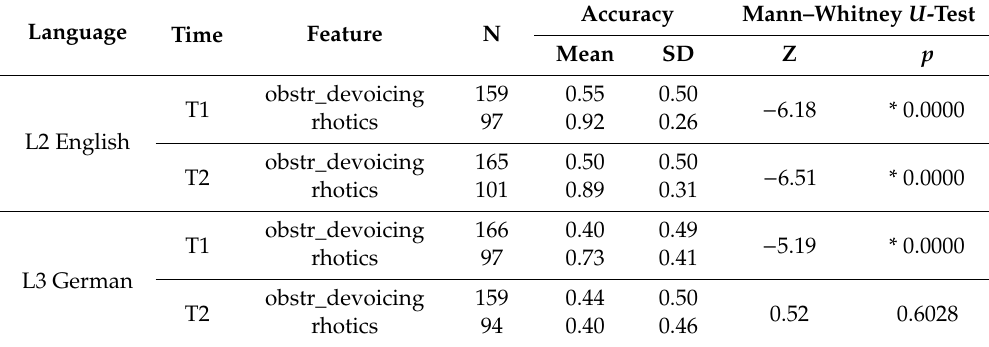
Table 5. Comparison of perception accuracy of features at T1 and T2.